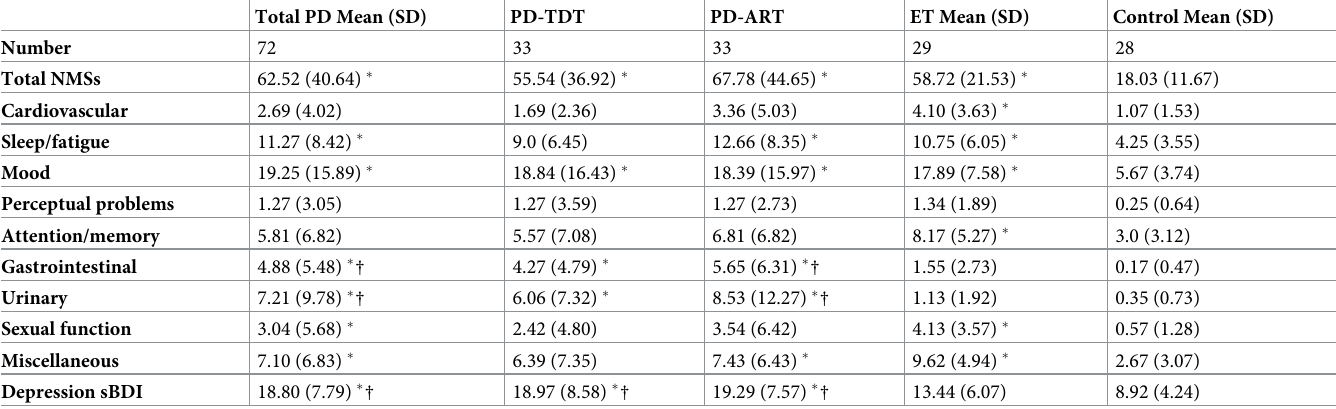
Table 2. Non-motor characteristics of PD subtypes, ET and